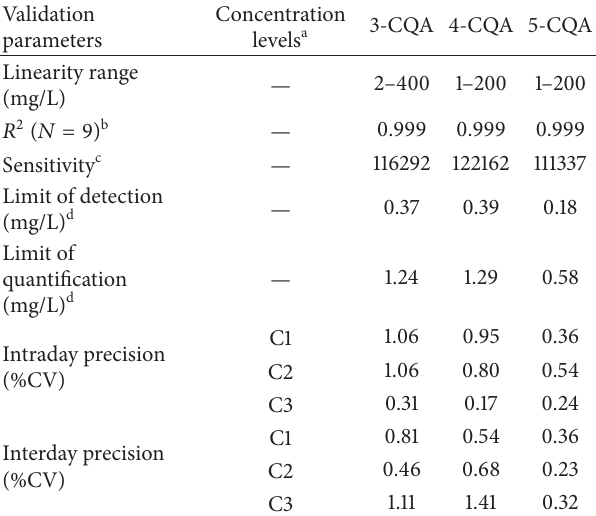
Table 3: Intraday precision and recovery of CQAs in coffee brews, spiked at two different concentration